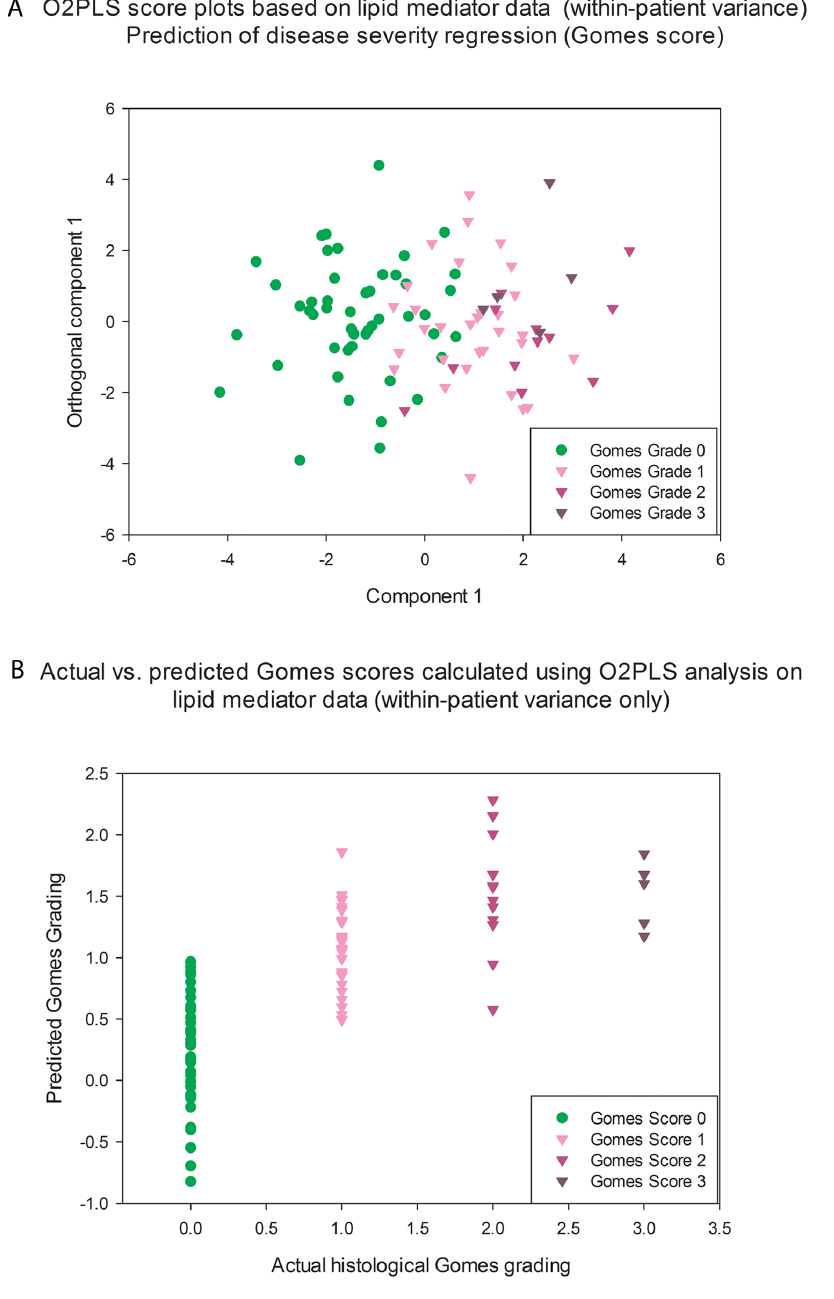
Figure 6. O2PLS model showing computed prediction of disease severity based on lipid mediator profile. 6A: Plot showing O2PLS regression score plots; 6B: plot showing actual vs. predicted GOMES score based on lipid mediator